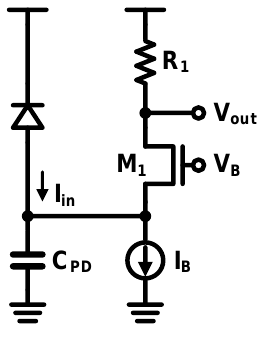
Figure 22. Common-gate TIA.